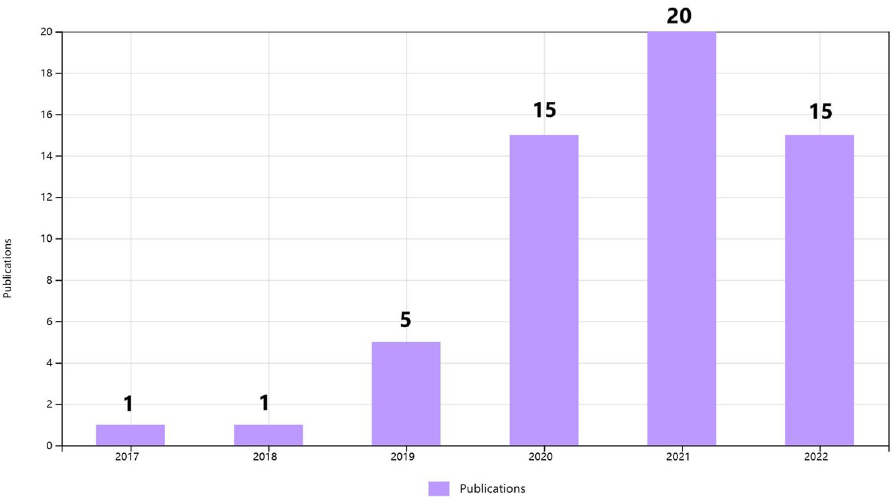
Figure 2. The distribution graph of the publication years of 57 articles based on the keywords of “convolutional neural network” and “plant disease severity” (from Web of Science).